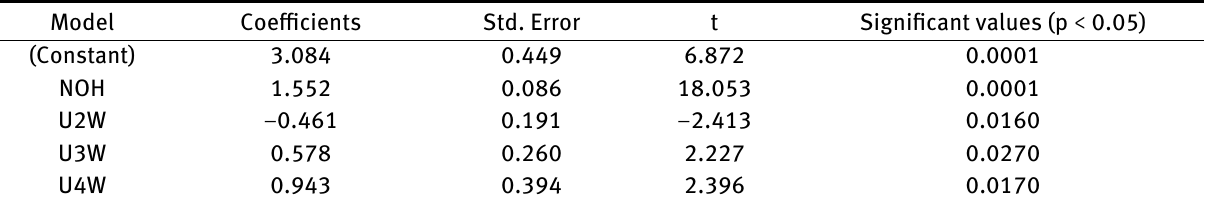
Table 8: Regression variable results for 16 hours